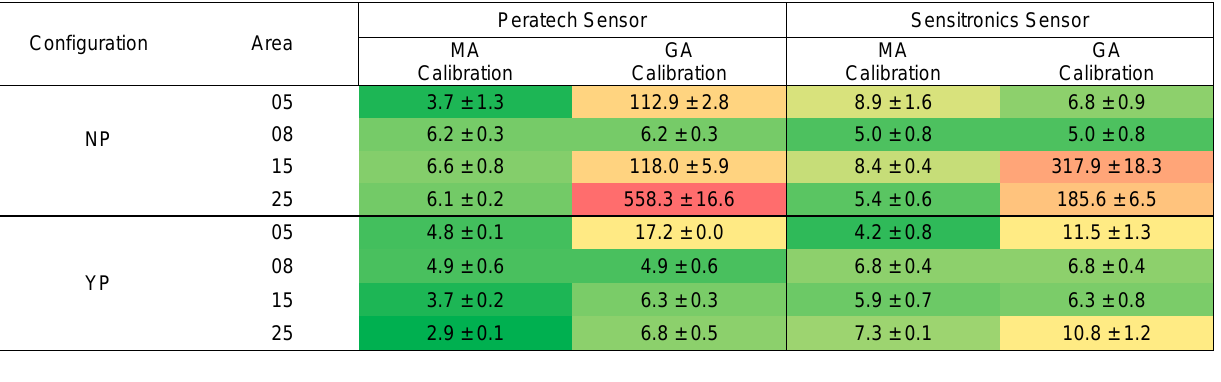
Table 3: Dynamic testing - NRMSE